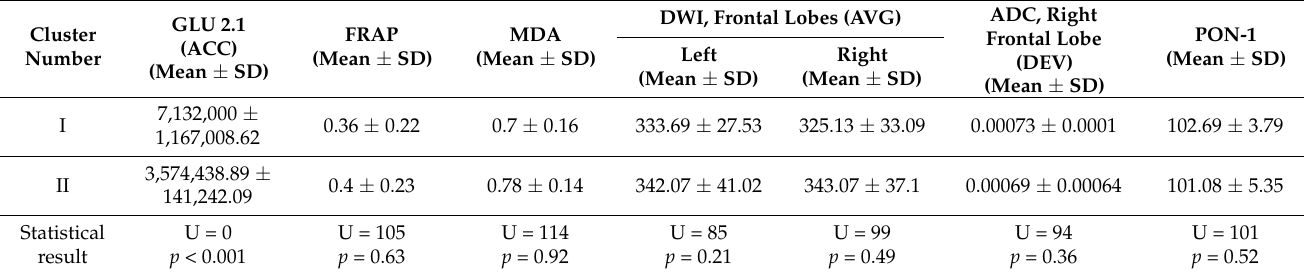
Table 5. Descriptive statistics concerning the selected clusters of patients for biochemical parameters and diffusion in the anterior cingulate